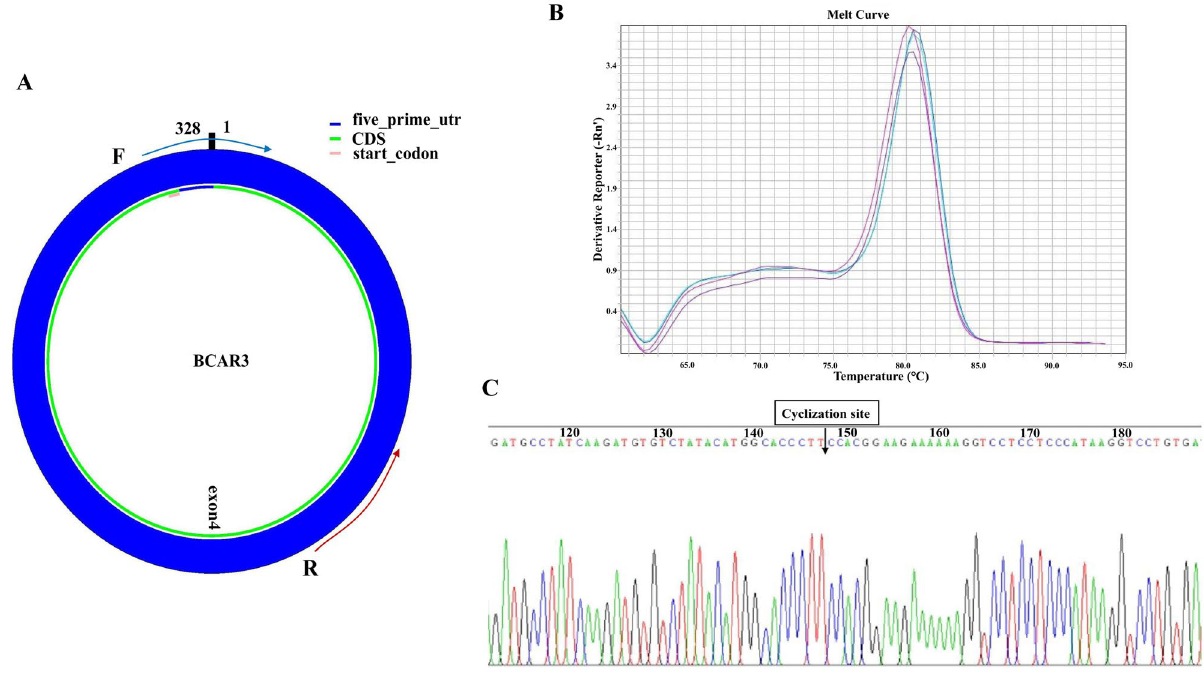
Figure 1. Amplification of hsa_circ_0006423. ( A ) hsa_circ_0006423 and divergent primers. Hsa_circ_0006423 comes from exon 4 of BCAR3, with a size of 328 nucleotides. The splice site sequence is in the forward primer. ( B ) Melting curves of hsa_circ_0006423 qRT-PCR products of three representative samples (the three colors represent three different samples). ( C ) Sanger sequencing results of hsa_circ_0006423. The arrow indicates the cyclization site. BCAR3 breast cancer anti-estrogen resistance 3, UTR untranslated region, CDS coding